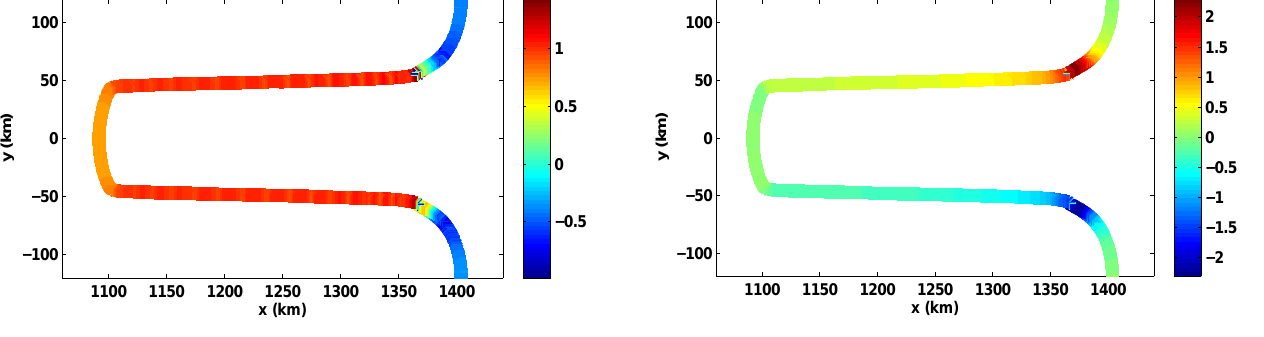
Fig. 2. The normal buttressing number K N (defined by Eq. 10). The value of K N is shown along the grounding line. The width of the coloured line in the plot is chosen for clarity and does not reflect the actual width of the grounding line. All model parameters are the same as for Fig. 1.